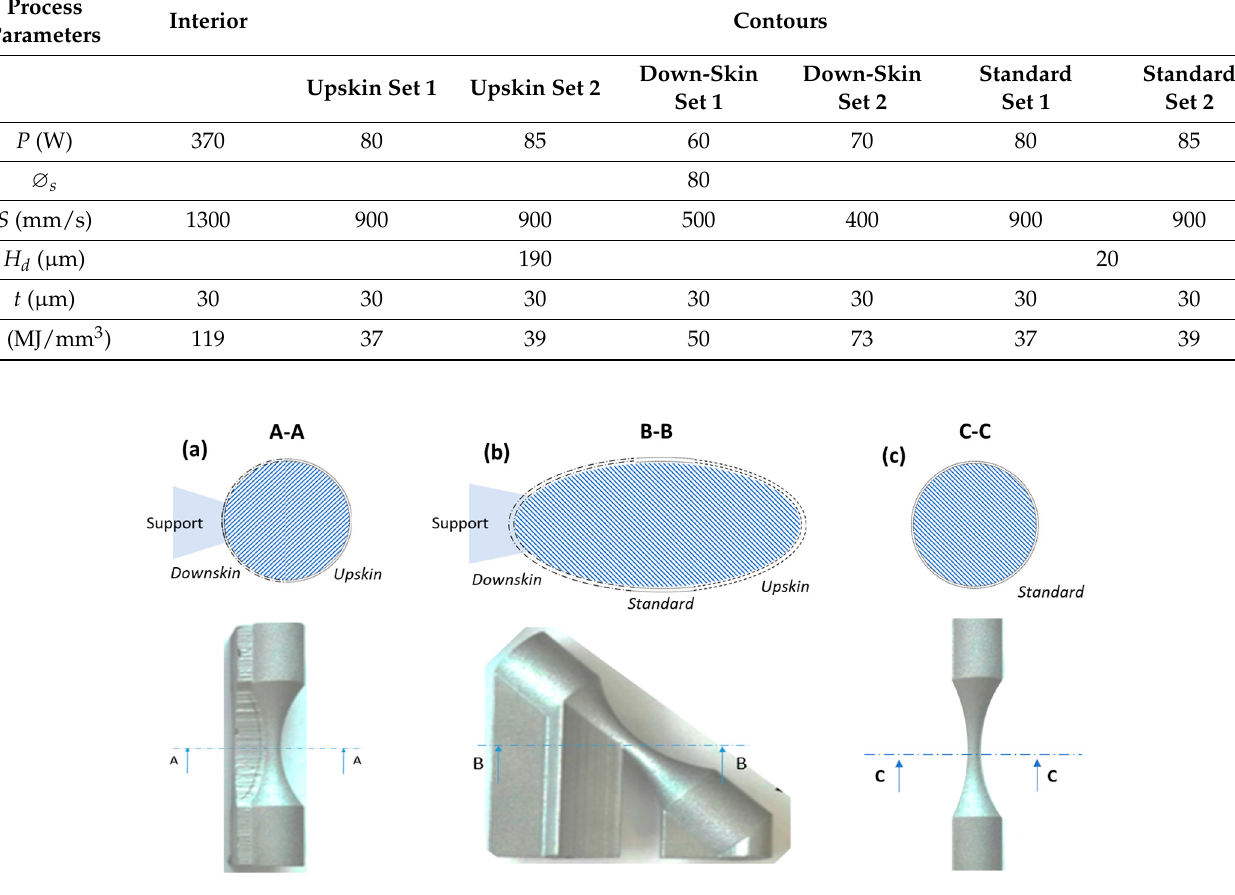
Figure 3. Contour scanning strategy, ( a ) XY sample, ( b ) Alpha45 sample, ( c ) Z sample. Table 1. Process parameters related to the building strategy and evaluation of the energy density (contour performed in two passes: set 1 and set 2).